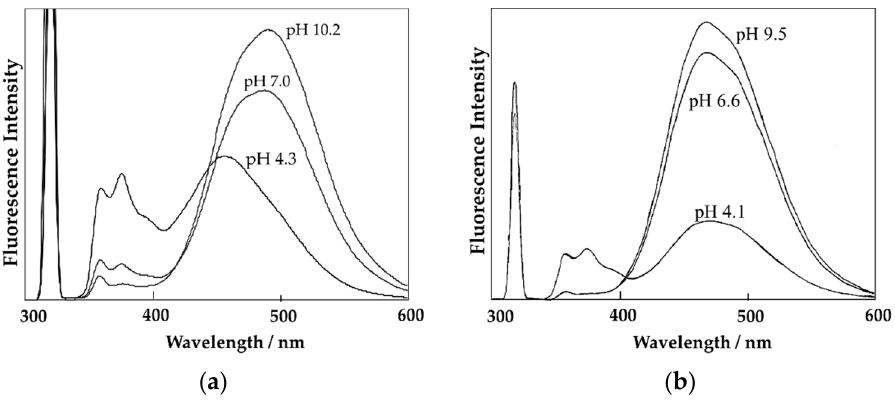
Figure 2. Fluorescence spectra of the VDP-labeled polymer solutions: ( a ) poly(VDP- co -AAc) and ( b ) poly(VDP- co -DMAM).